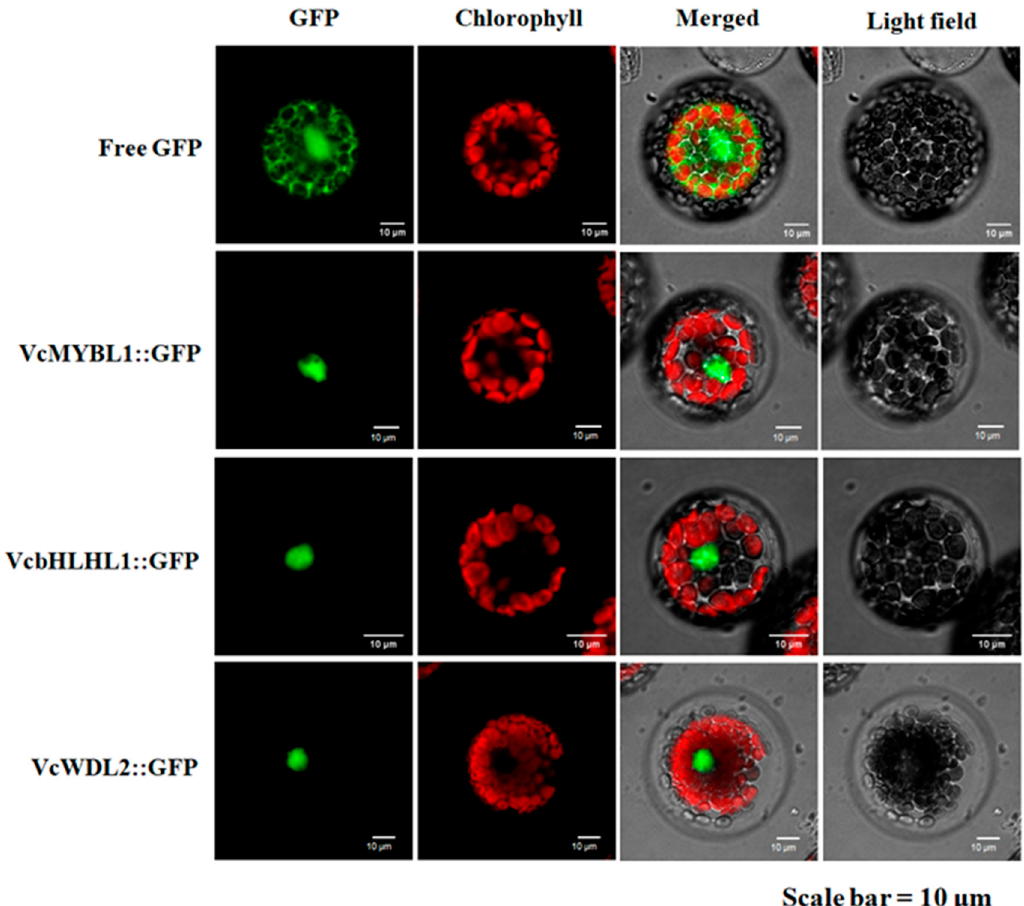
Figure 4: Subcellular localization of free green fluorescent protein (GFP), VcMYBL1::GFP, VcbHLH1::GFP, and VcWDL2::GFP. The chloroplasts have red chlorophyll autofluorescence.